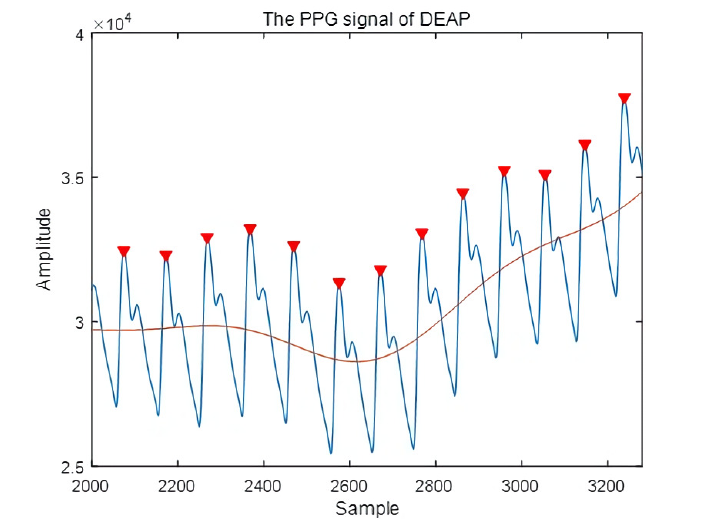
Figure 3. Original PPG signal. DEAP, Database for Emotion Analysis using Physiological